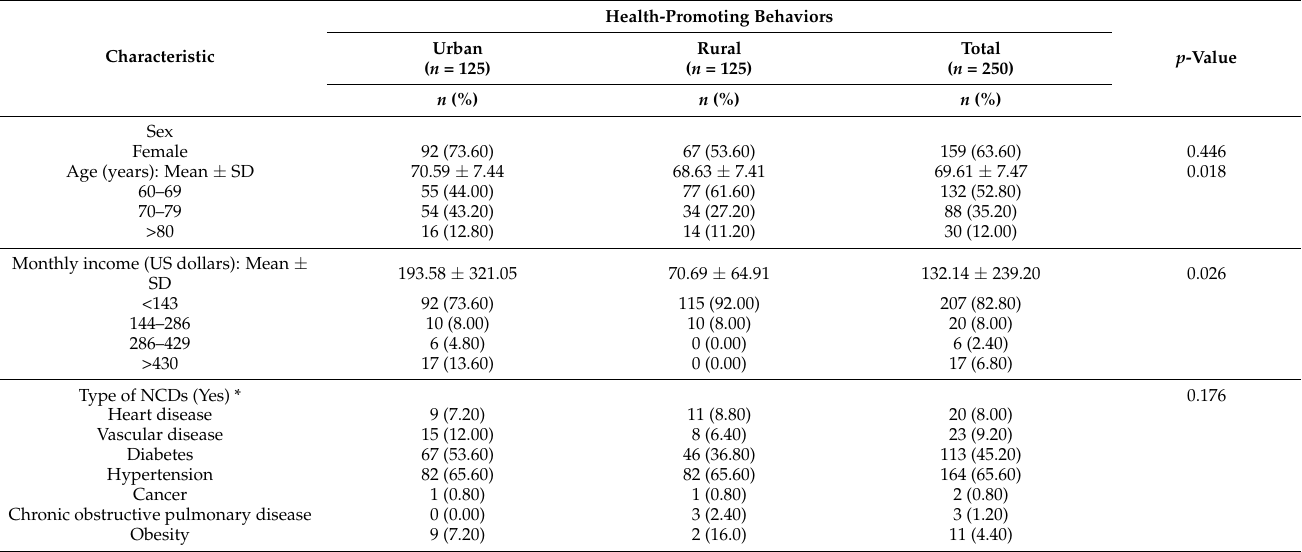
Table 1. Participants’ demographic